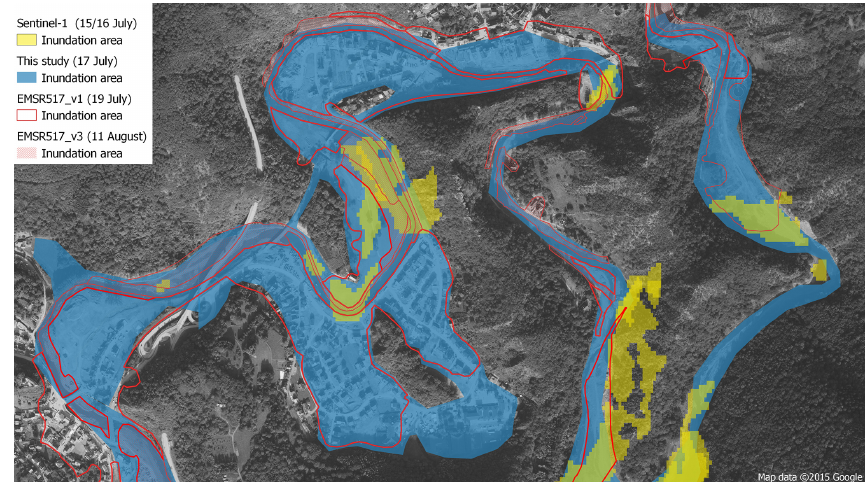
Figure 11. Comparison of the inundation area (municipality of Altenahr): based on our method (in blue) from 17 July, results based on Sentinel-1 (in yellow; DLR, 2021) from 15 / 16 July, and results of the Copernicus Emergency Management Service (CEMS, 2021) from 19 July (EMSR517_v1, red contour) and 11 August (EMSR517_v3; red hatched; © Google Earth). For a photo comparison of the river loop before and during the flood see also the following tweet on Twitter: https://twitter.com/WxNB_/status/1415629704472760324 (last access: 13 November